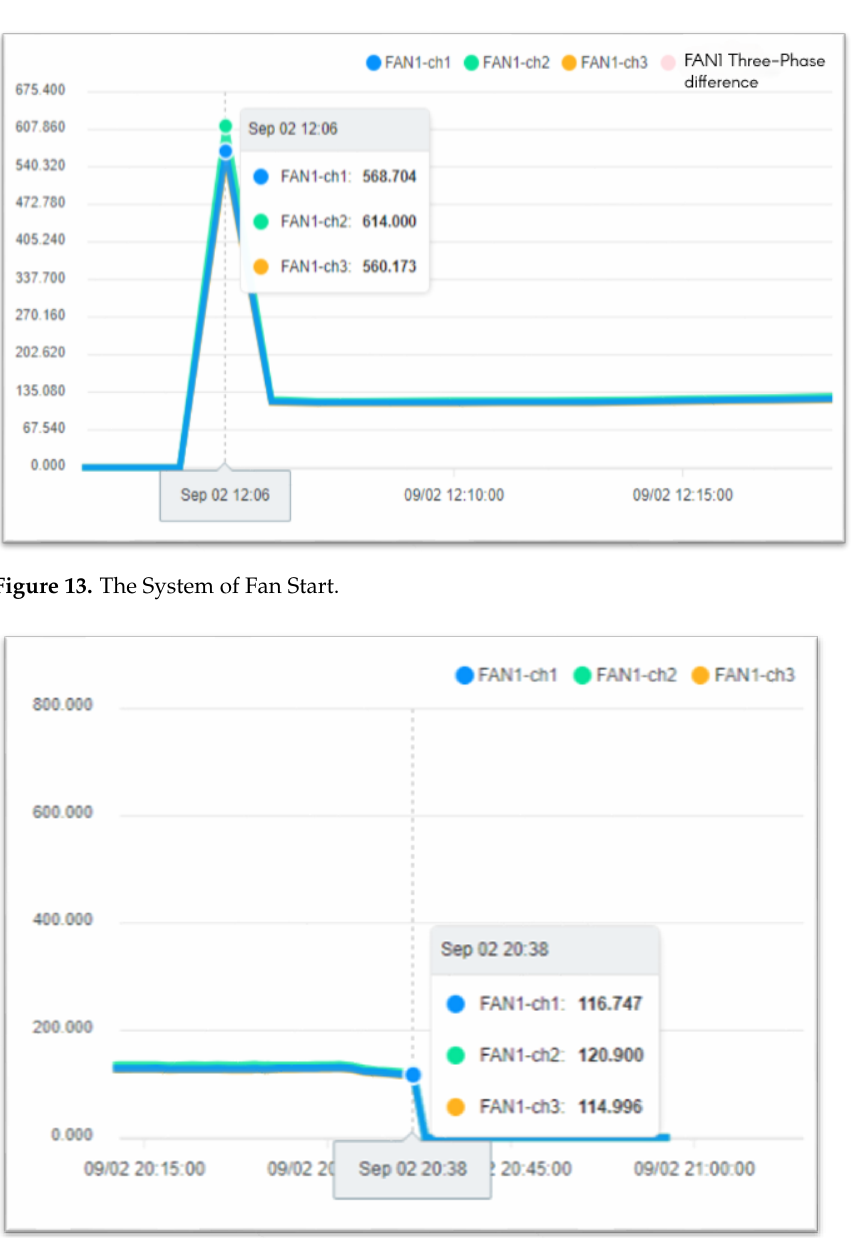
Figure 14. The System of Fan stops at the end of the